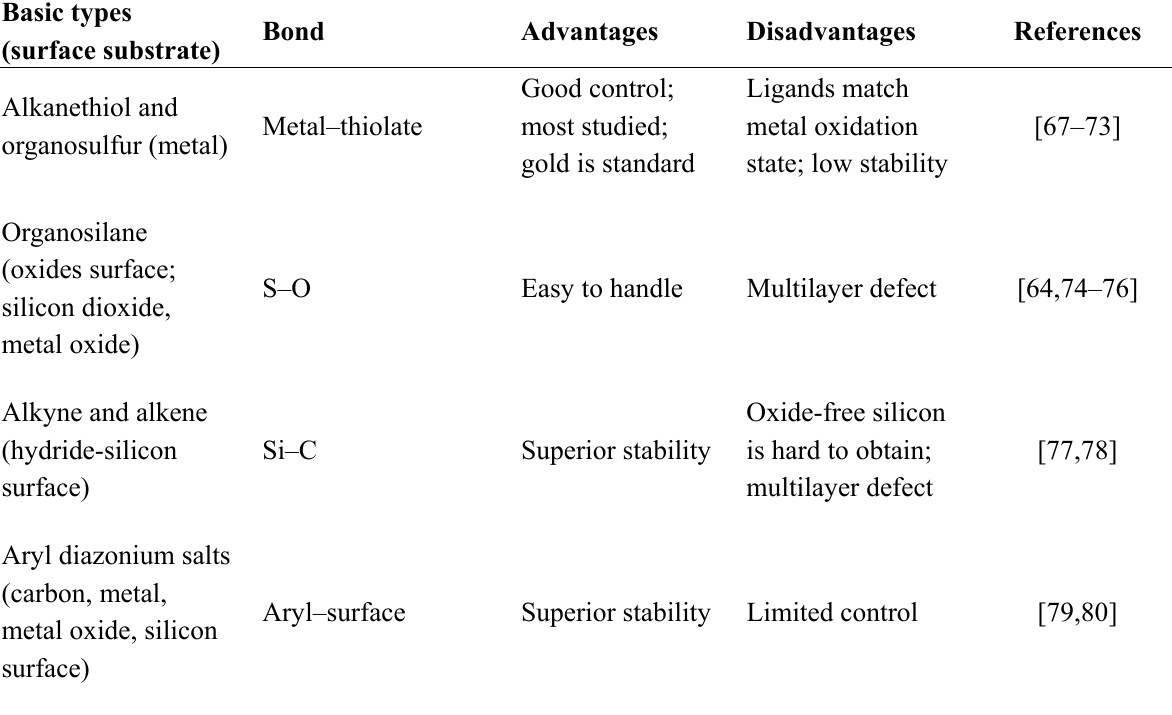
Table 2. Four types of SAM